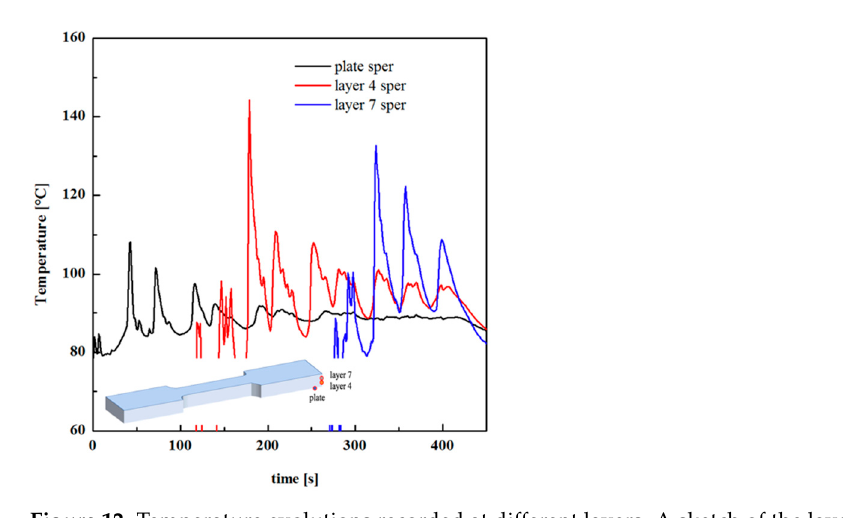
Figure 12. Temperature evolutions recorded at different layers. A sketch of the layers is also